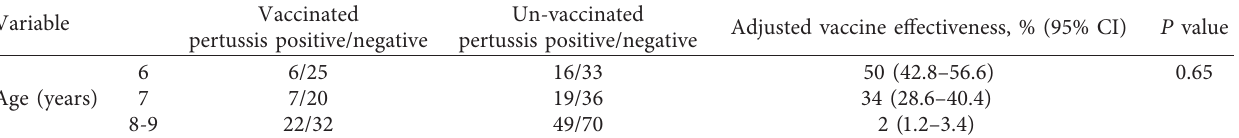
Table 4: Adjusted estimates of pertussis vaccine protective effectiveness among different age categories.